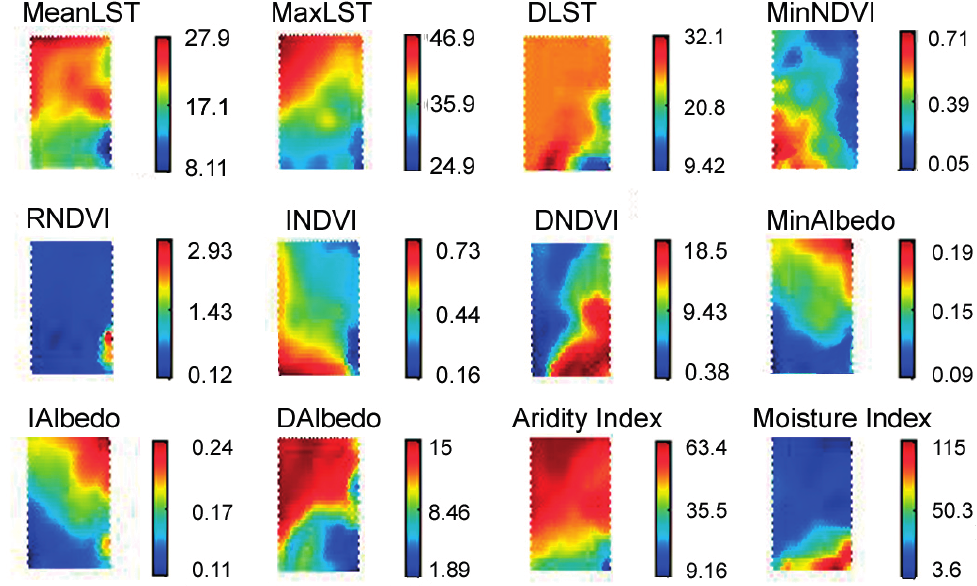
Figure 6. Visualization of the two-plane components of the SOM trained from time series of NDVI, Albedo, LST and climatic data in Spain used as input to derive the EFTS.